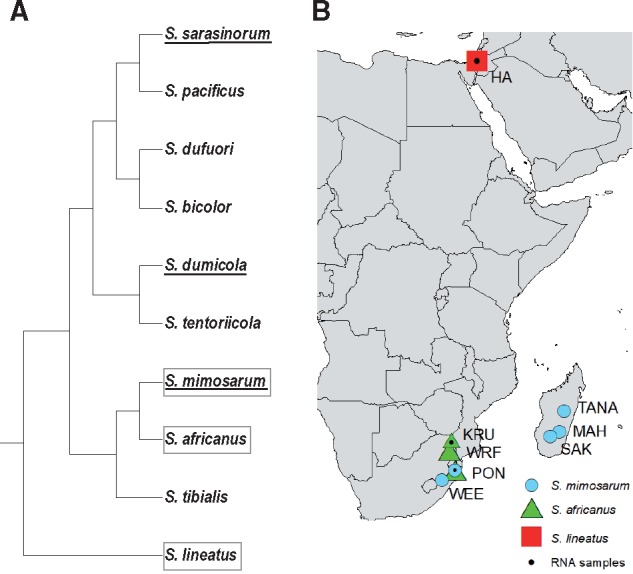
Study system. (a) Phylogeny of the spider genus Stegodyphus (modified after Settepani et al. 2016). Social species are underlined, and the species included in this study are boxed in gray. (b) Geographic location of sampled S. mimosarum populations (MAH, SAK, TANA, WEE, PON) and of S. africanus populations (WRF, PON, KRU).